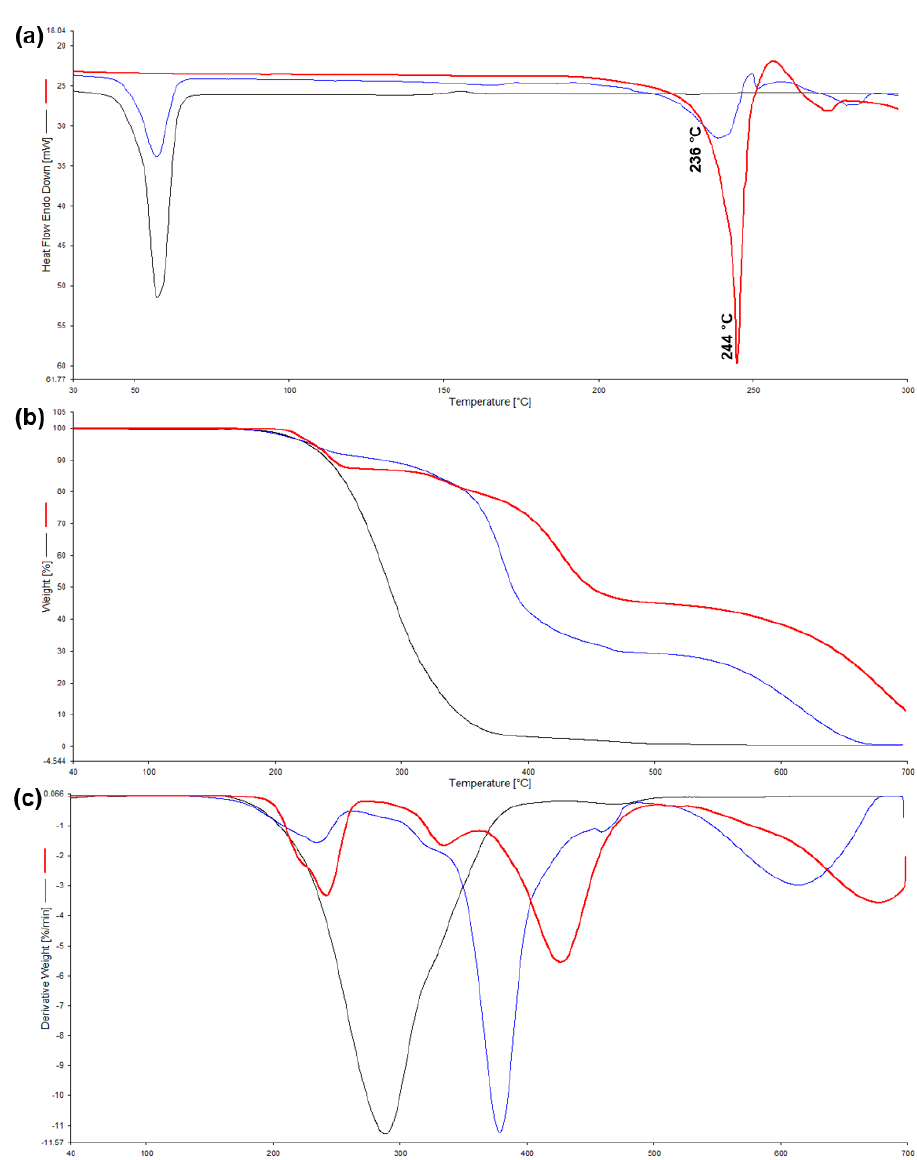
Figure 4. Thermal behaviour of P 407—DSC ( a ), TGA ( b ), and DTG ( c ) at a heating rate of 10 °C min − 1 . Fen (red), neat polymer (black), and physical mixture (blue).